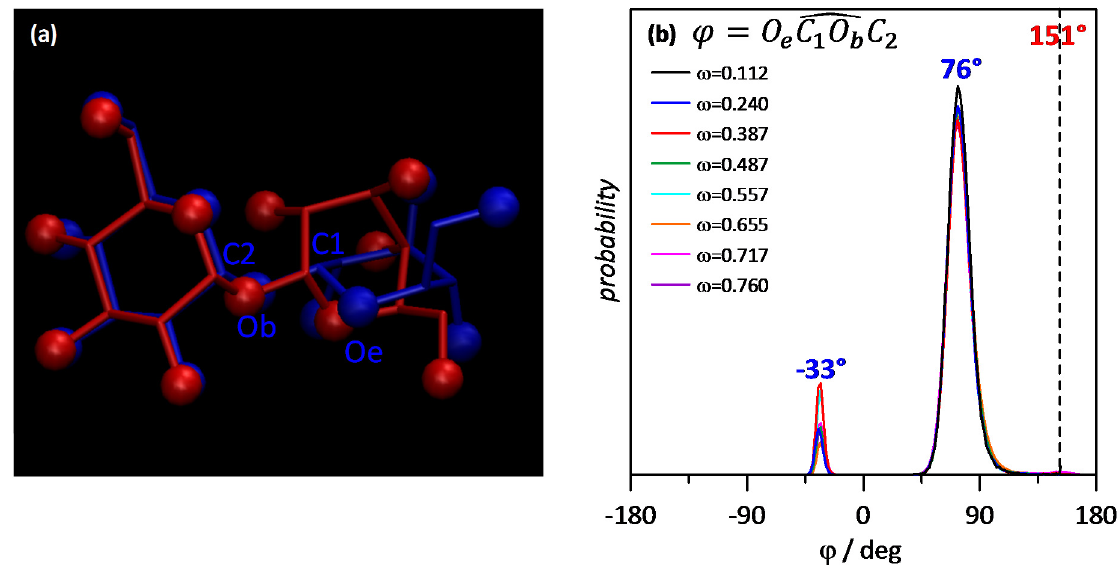
Figure 16. ( a ) Comparison of (red) structure of THAL molecule optimized (DFT) in gas phase and (blue) average structure of THAL molecule in ω THAL + (1- ω ) water mixtures ( ω = 0.112) at 310 K. Oxygen atoms are showed as van der Waals spheres; hydrogen atoms are omitted for the sake of visibility. ( b ) Probability distribution plots of the reported dihedral angle in ω THAL + (1- ω ) water mixtures at 310 K. In panel b, dashed line shows the value of the dihedral in gas phase, and the peaks correspond to ω THAL + (1- ω ) water mixtures.